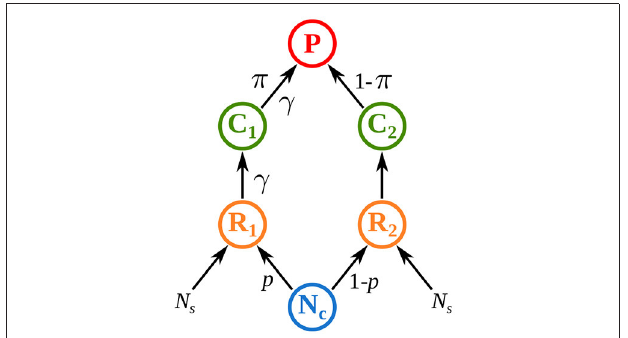
FIGURE 1 | Model of Rooney et al. (2006) where top predators P couple two food chains consisting of a resource R and a consumer C . Both resources feed on a common nutrient pool N c . Interaction strength between R 1 and C 1 and between C 1 and P is γ times higher than in food chain 2. A fraction p of nutrients from the common pool N c is absorbed by R 1 . Top predators preferentially prey on the consumer that has the highest biomass density C 1 / ( C 1 C 2 ) defines the preference for C 1 ). See Equation (11) and ( π = + Supplementary Table S1-2 in the Supplementary Material for a detailed description of the model and its